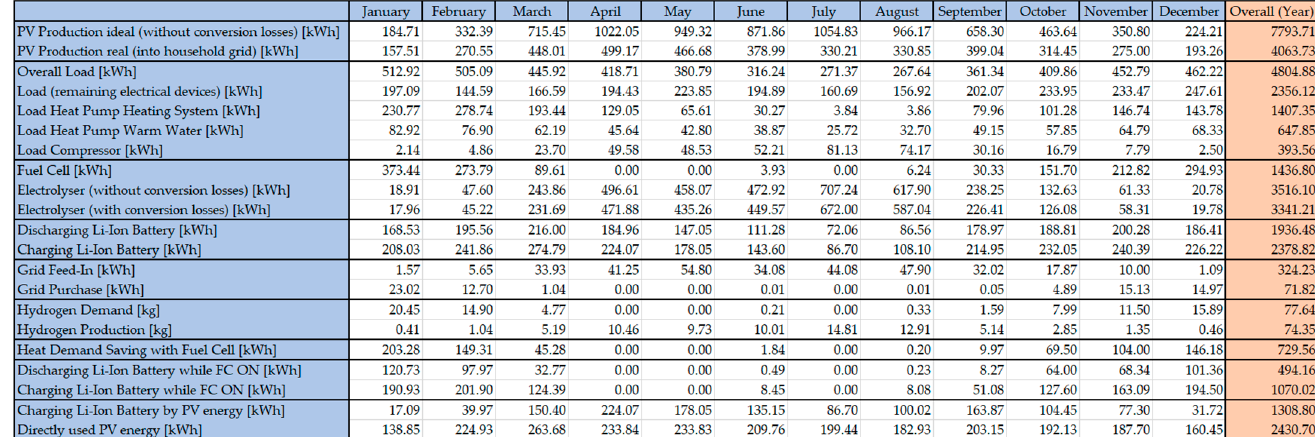
Figure 14. Monthly outcomes of the component energy productions and requirements for the base use case. The “PV Production real” describes the energy which was not used inside the ELY for production of hydrogen.